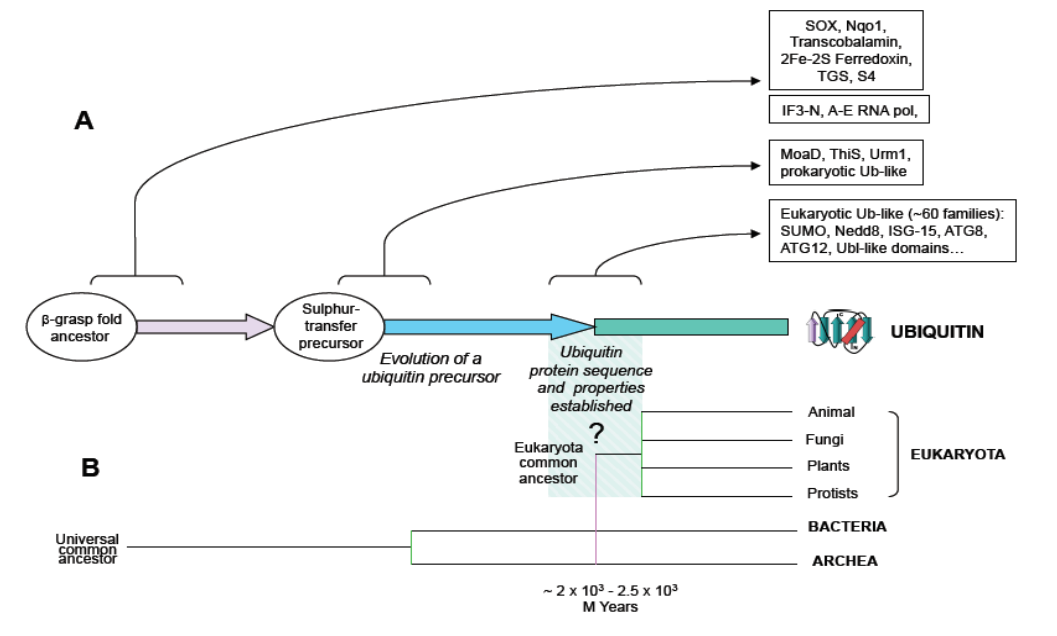
Figure 1. Schematic representation of ubiquitin evolution from an ancestral beta-grasp fold gene. ( A ) Beta-grasp fold is found in multiple protein families in prokaryotes and eukaryotes. Arrows show functional diversification at the levels of: beta-grasp fold ancestor, sulphur transfer precursor and ubiquitin-type families, and boxes contain groups of proteins, as reported in (3). ( B ) An evolutionary tree including branches of main groups is shown, and the origin of eukaryotes is hypothetically linked to the origin of